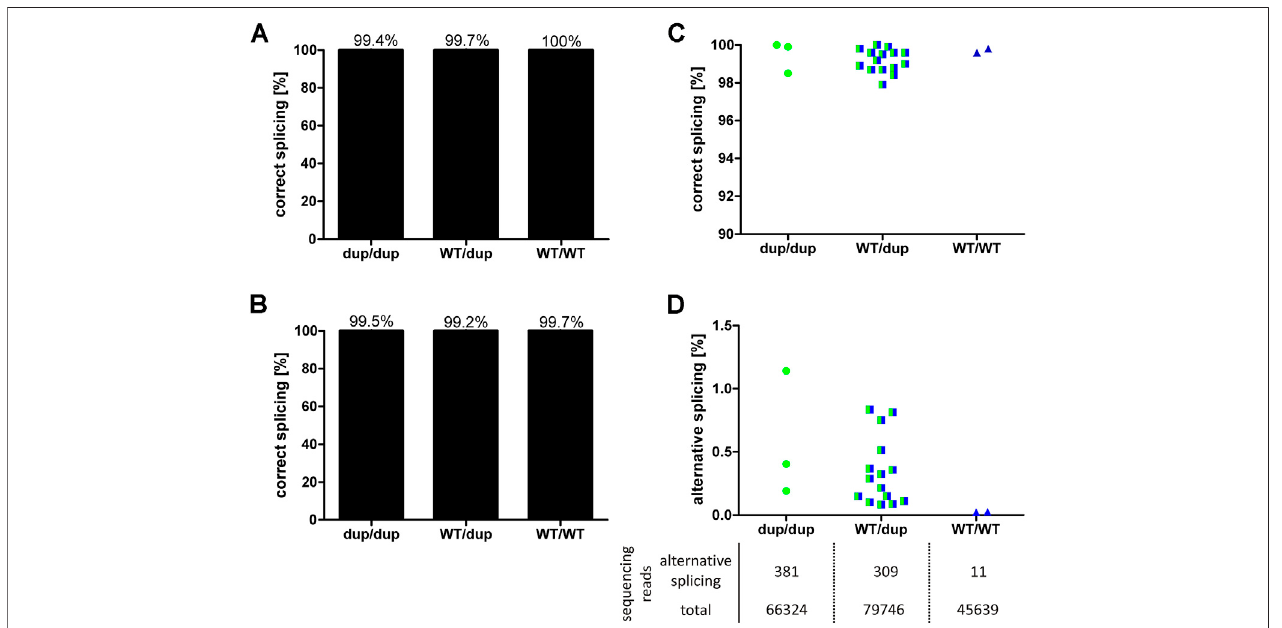
FIGURE 4 | Effects of rs35854239 on OCT1 splicing in human liver samples. Splicing of the exon7-intron7 junction of OCT1 mRNA, depending on rs35854239 genotype was quanti fi ed using (A) pyrosequencing and (B) deep RNA-sequencing. On the left, the mean percentage of correctly spliced transcripts depending on the rs35854239 genotype is shown. The percentage of (C) correctly and (D) alternatively spliced transcripts for each individual sample is shown. (D) The mean sequencing depth for alternatively spliced and total transcripts is stated below. Dup, rs35854239 duplication allele; WT, wild-type SLC22A1 allele. Dup/dup: n (cid:2) 3, WT/dup: n (cid:2) 15, WT/WT: n (cid:2)